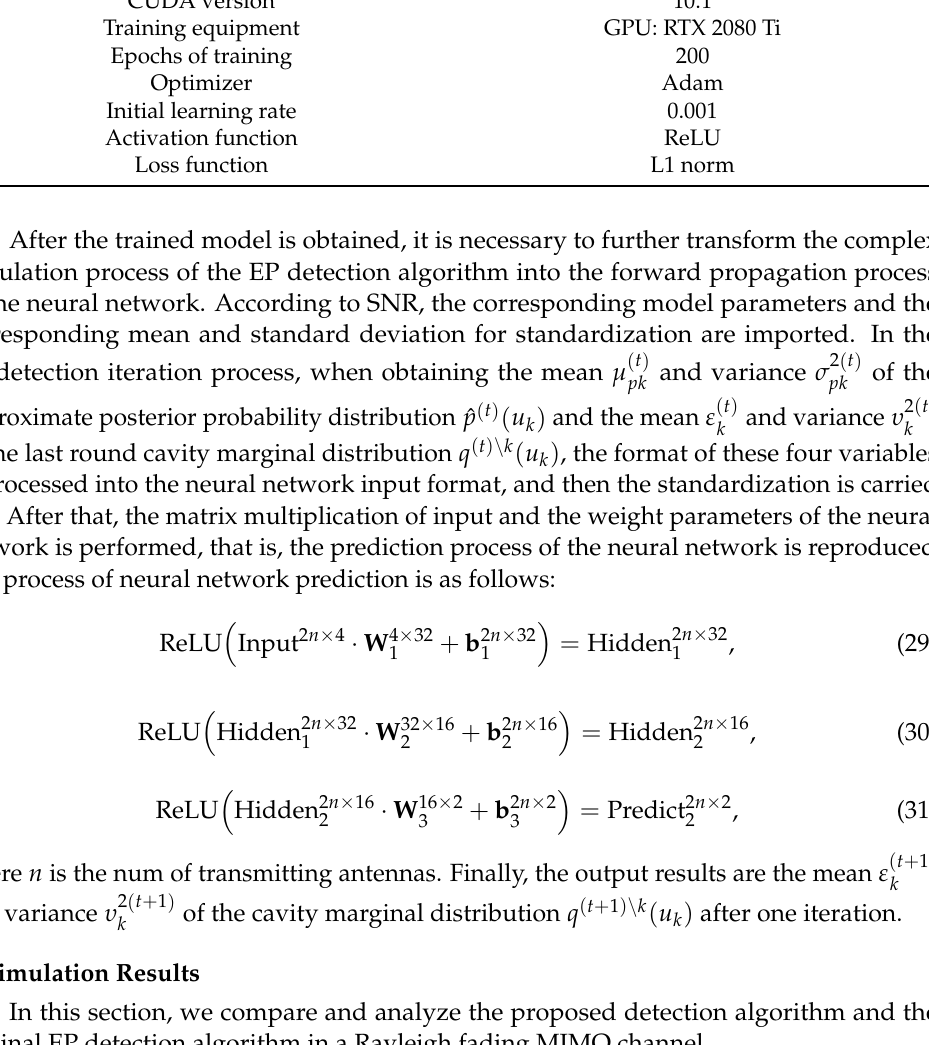
Table 2. Parameters of neural network module. Parameters Values Programming language Python3.7 Implementation framework Pytorch